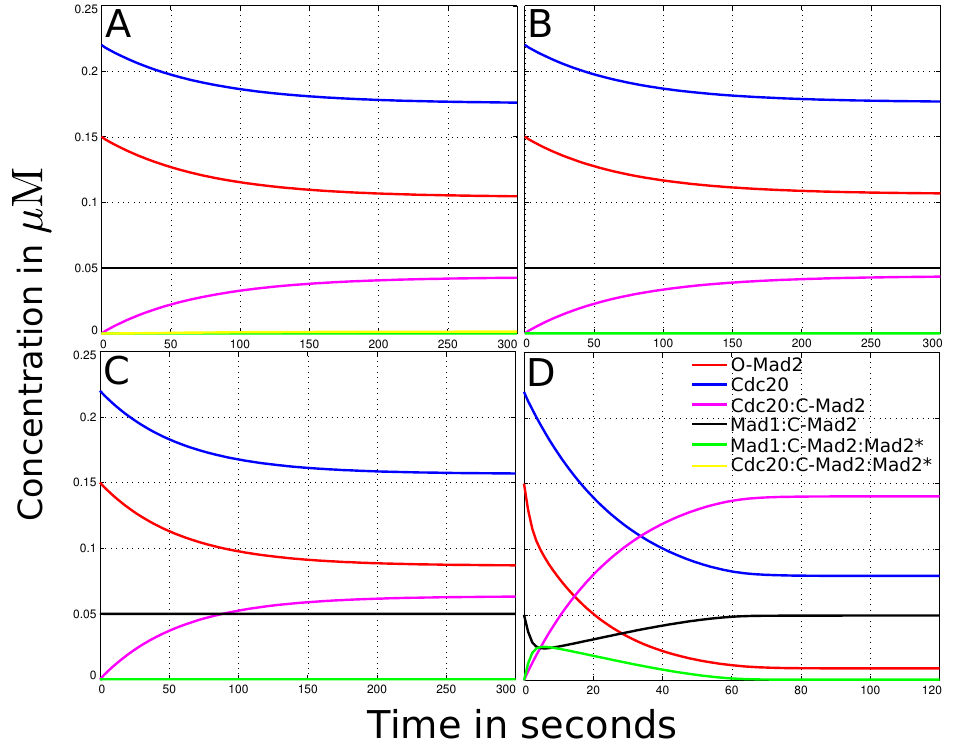
Figure 1. Dynamical behavior of the spatial human SAC model. The figures show the total concentrations over time for every species with different parameter sets. ( A ) Outcome of the simulated “Mad2 template” model (experimental interactions, diffusion rates and no convection, cf. Table 1). It takes about 5 min to reach steady state. O-Mad2 and Cdc20 are reduced to 70% and 80% of their initial amount, respectively. Cdc20:C-Mad2 has a concentration of 4 . 3 × 10 − 2 µM ( 20% of Cdc20) in the steady state. According to literature, this amount is not enough and its formation too slow to dissipate the “wait anaphase” signal. Mad1:C-Mad2 and Mad1:C-Mad2:Mad2* do not change their concentration over time and thus do not contribute to the formation of Cdc20:C-Mad2 significantly; ( B ) The results of the reduced “template model” (slow diffusion constant and deleted reactions (4) and (5)) do not deviate significantly from the full model, cf. panel A. Neither the amount of Cdc20:C-Mad2 is increased nor the time it takes to reach steady state decreased. Thus, the autocatalytic loop, especially the formation of the Cdc20:C-Mad2:Mad2* complex, has no influence on the model and can be omitted; ( C ) The simulation of the model with a 4-fold higher diffusion = 20 µ m 2 s − 1 ). The species’ dynamical behavior is qualitative the constant of O-Mad2 (D i same as in the standard simulation (panel B). However, with a higher diffusion constant the final amount of Cdc20:C-Mad2 increased to 6 . 3 × 10 − 2 µM ( 29% of Cdc20), whereby O-Mad2 and Cdc20 are decreased to 57% and 71% of their initial concentration, respectively; ( D ) The simulation of the model with an active transport of O-Mad2 ( cf. Equation (13)). It takes 1 − 2 min to reach steady state. The active transport of O-Mad2 towards the kinetochore promotes the rates of reactions (2) and (3). Thus, the inhibition level of Cdc20 raises to 60% of its total amount. Mad1:C-Mad2 and Mad1:C-Mad2:Mad2* catalyze the formation of Cdc20:C-Mad2 and reduce free Mad2 to 11% of its initial